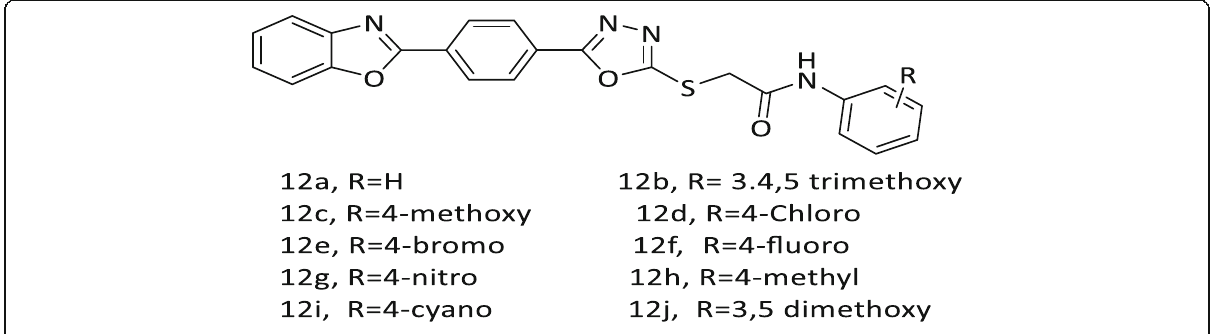
Fig. 3 Benzoxazole-1,3,4 oxadiazole derivatives